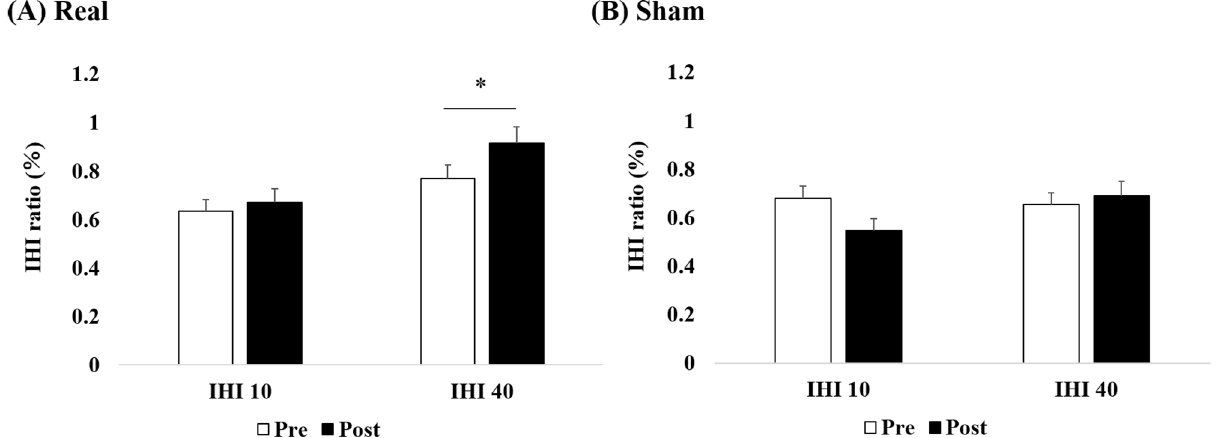
Figure 4. the effects of tSMS on IHI from the left to the right hemisphere. For real condition ( A ), the main effects of Time and IHI were significant. However, the interaction was not significant. Additional post-hoc t-test revealed the significant increase in IHI40 but not in IHI10 (*p < 0.05). For sham condition ( B ), no significant difference was found. Error bar are standard errors of the